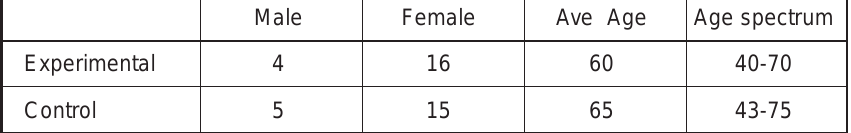
Table 1.1: Demographics of subjects that participate in study group.